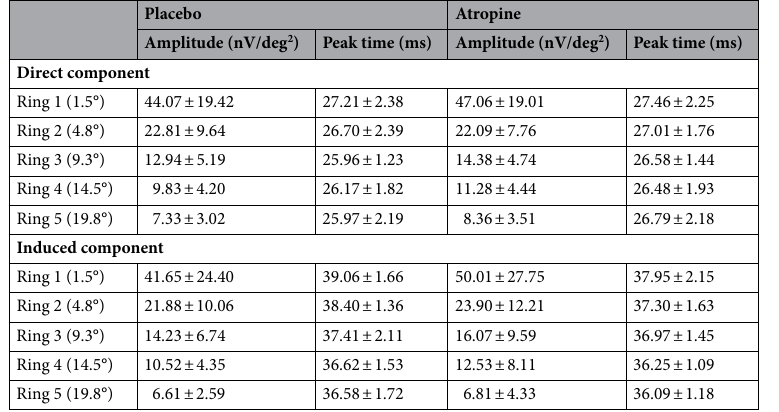
Table 2. Baseline MOFO mfERG at different retinal eccentricities (mean ± SD). No significant difference in any ERG parameters between 2 groups by repeated-measure ANOVA. DC Amplitude: Ring*Treatment F = 0.38, p = 0.82; Peak time: Ring*Treatment F = 0.89, p = 0.87. IC Amplitude: Ring*Treatment F = 1.38, p = 0.24; Peak time: Ring*Treatment F = 1.09, p = 0.36. ERG parameters were independent of baseline age, spherical equivalent refraction, and axial length.